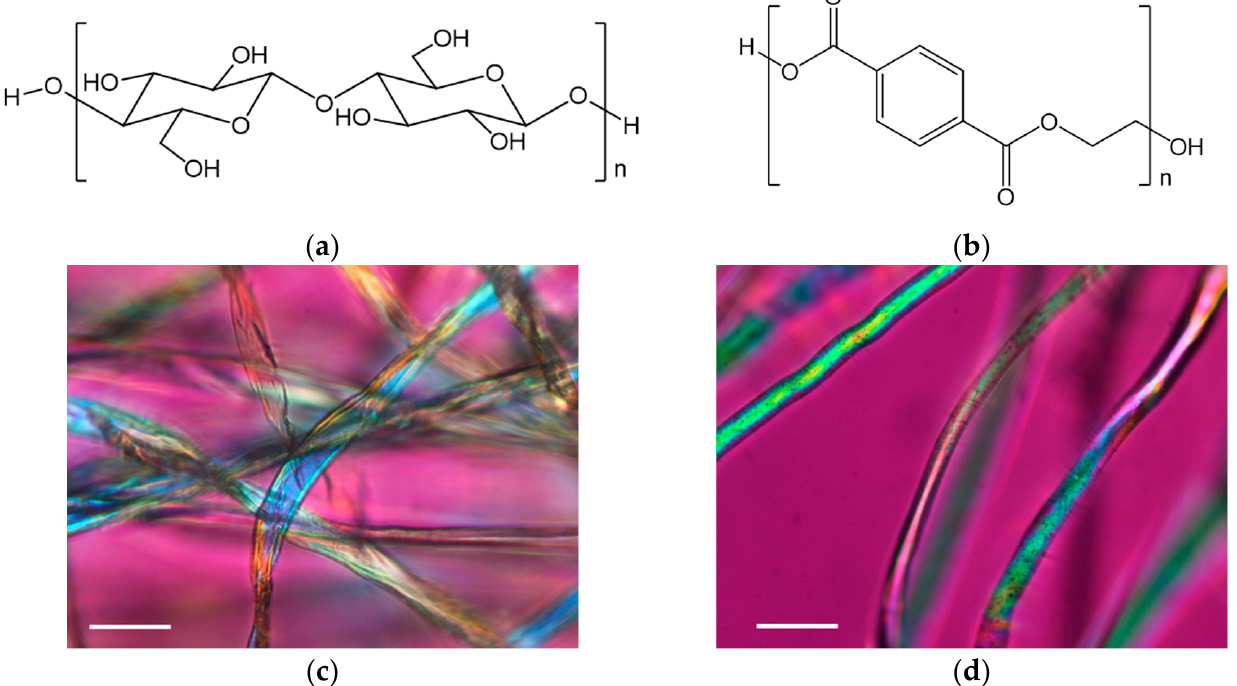
Figure 2. Chemical structures of ( a ) two glucose repeat units in cellulose and ( b ) an ethylene terephthalate repeat unit in poly(ethylene terephthalate). Polarized light microscopy images of ( c ) cotton and ( d ) polyester fibers (authors’ original images; scale bars 50 μ m).